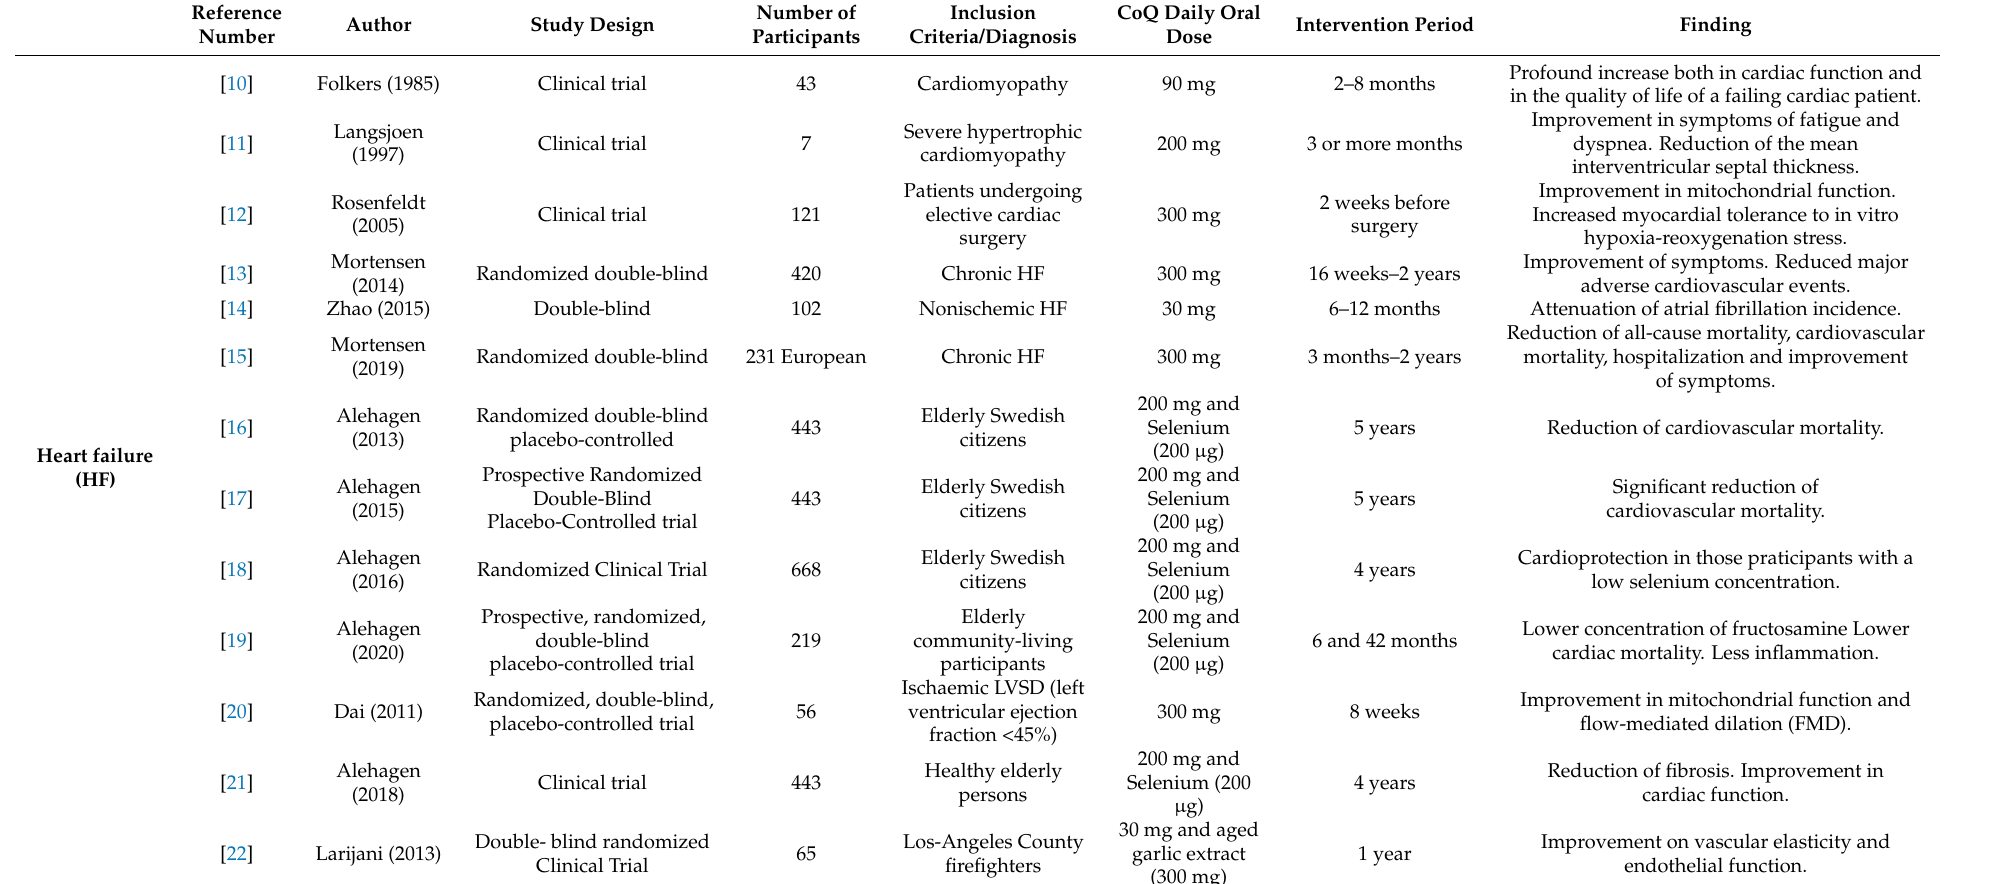
Table 1. Clinical trials and meta-analyses of CoQ10 in heart failure (HF), coronary artery disease (CAD), hypercholesterolemia, atherosclerosis, endothelial dysfunction and hypertension. N/A: not